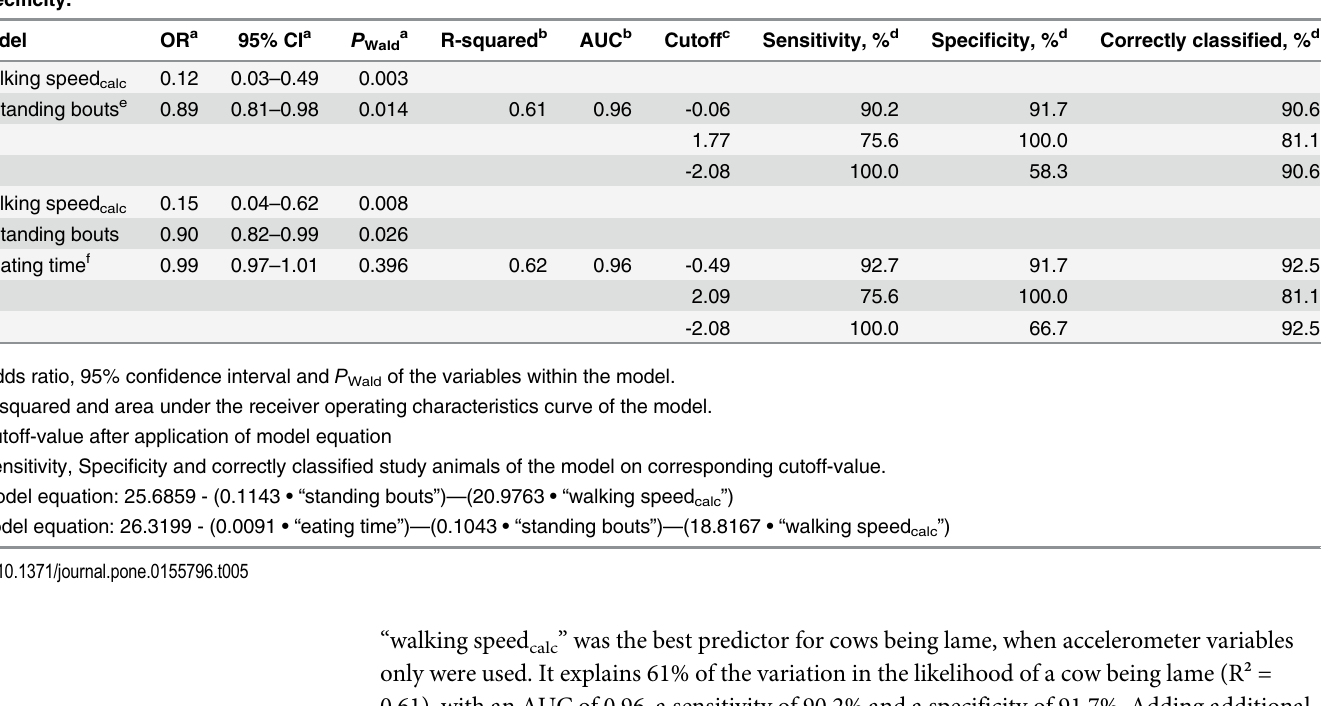
Table 5. Using different RumiWatch noseband sensor and accelerometer (RumiWatch, ITIN+HOCH GmbH, Fütterungstechnik, Liestal, Switzer- land) variable combinations as predictors of a cow being lame (numerical rating system according to Flower and Weary[38], NRS (cid:1) 2.5) in multi- variable logistic regression and receiver operating characteristics analysis on different cutoff-values with corresponding sensitivity and specificity. Model